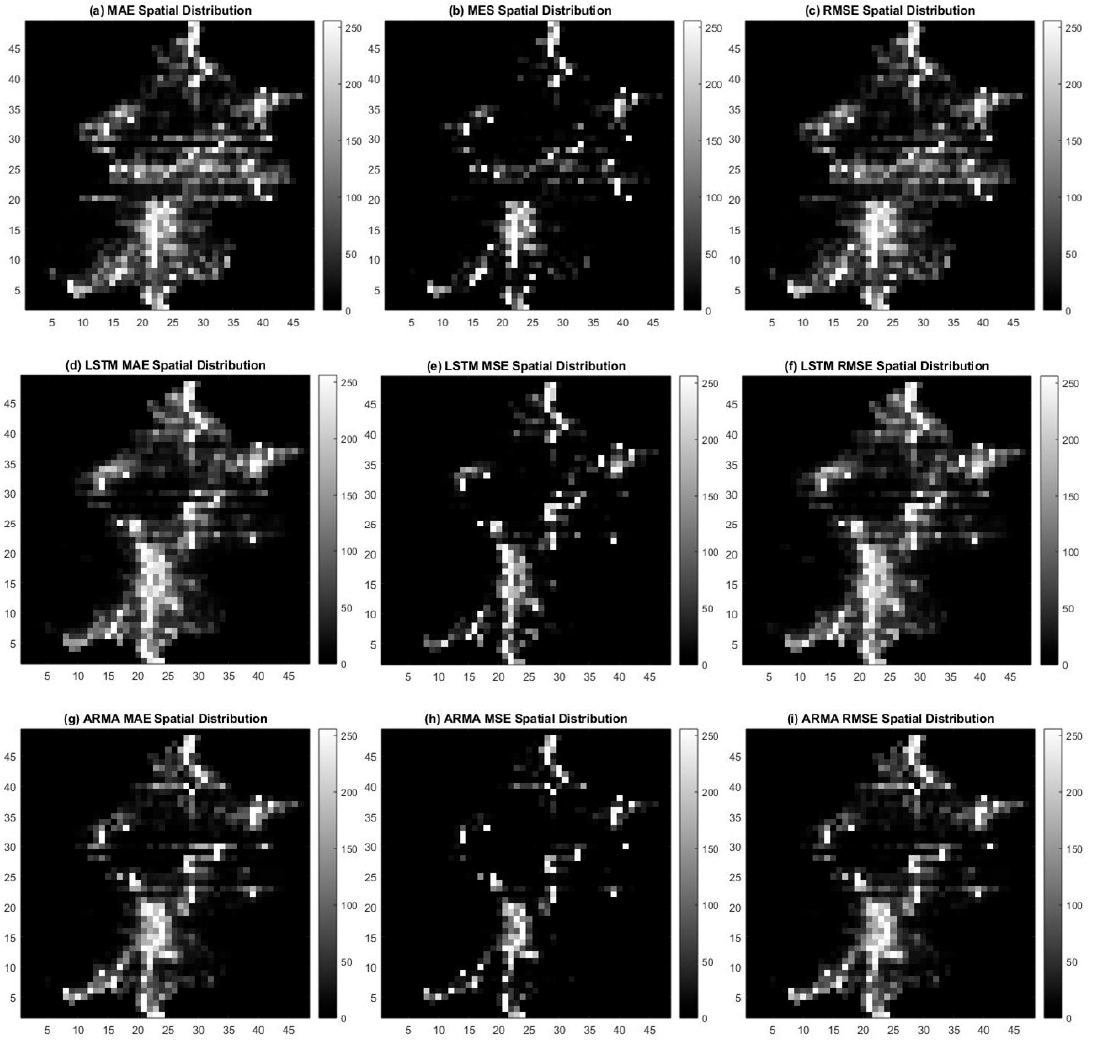
Figure 19. The spatial distribution of errors on 17 February 2015 for the three methods: ( a – c ) are the result maps for the mean absolute error (MAE), mean squared error (MSE), and root-mean-squared error (RMSE) distributions generated by ConvLSTM; ( d – f ) are the results generated by the LSTM model in the same order, while ( g – i ) are those generated by the ARMA